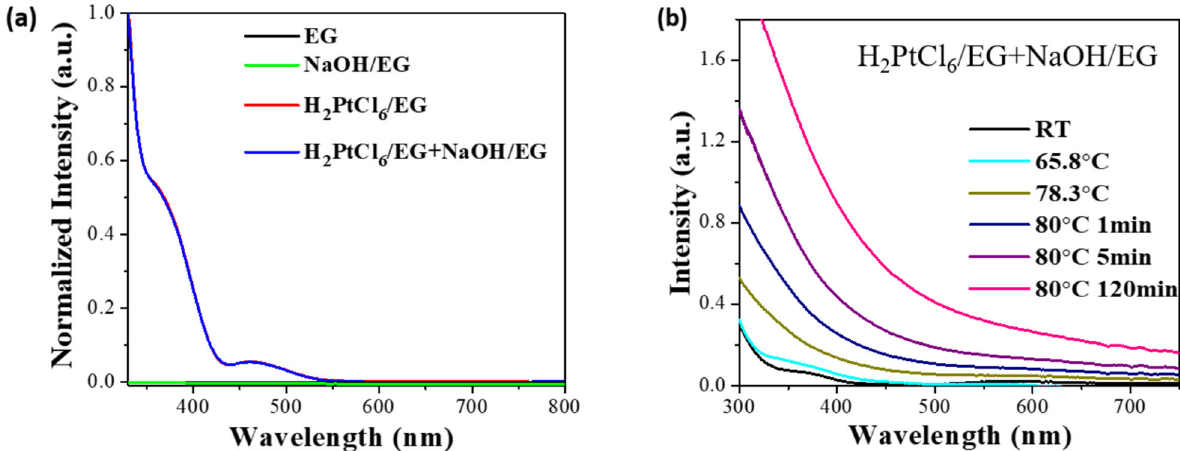
Figure 3. UV-vis absorption spectra. ( a ) The absorption spectra of EG, H 2 PtCl 6 /EG, NaOH/EG and the mixed solution of H 2 PtCl 6 /EG and NaOH/EG. ( b ) The in situ absorption spectra of reaction mixture for preparing unprotected Pt nanoclusters during reduction. Reproduced with permission,